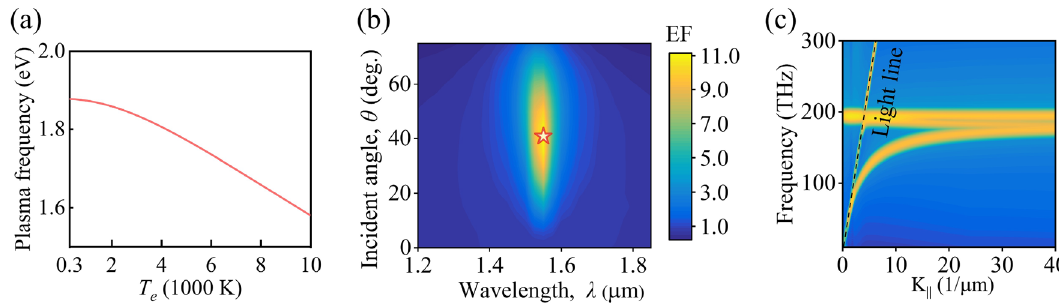
Figure 2. ( a ) Calculated plasma frequency ω p as a function of hot-electron temperature T e . ( b ) Simulated enhancement factor as a function of wavelength and incident angle. The red star symbol indicates a maximum value. ( c ) Dispersion relation of the TCO